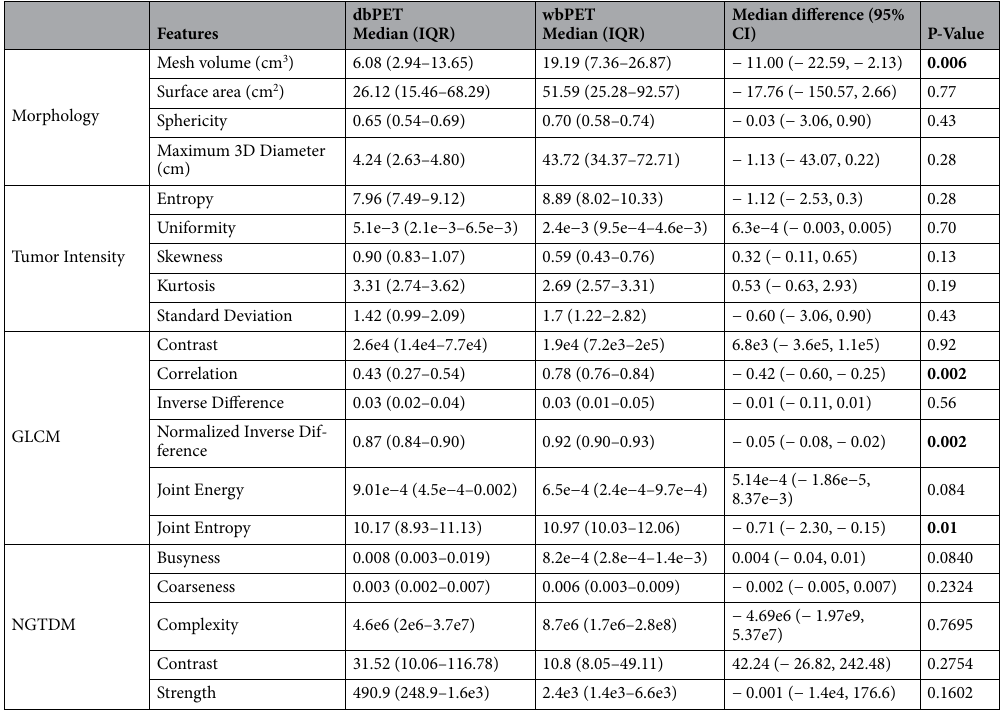
Table 3. Summary of radiomics features for dbPET and wbPET. Statistical significance, median difference, and 95% confidence intervals were assessed using the Wilcoxon signed-rank test. GLCM gray-level co-occurrence matrix, NGTDM neighborhood gray-tone difference